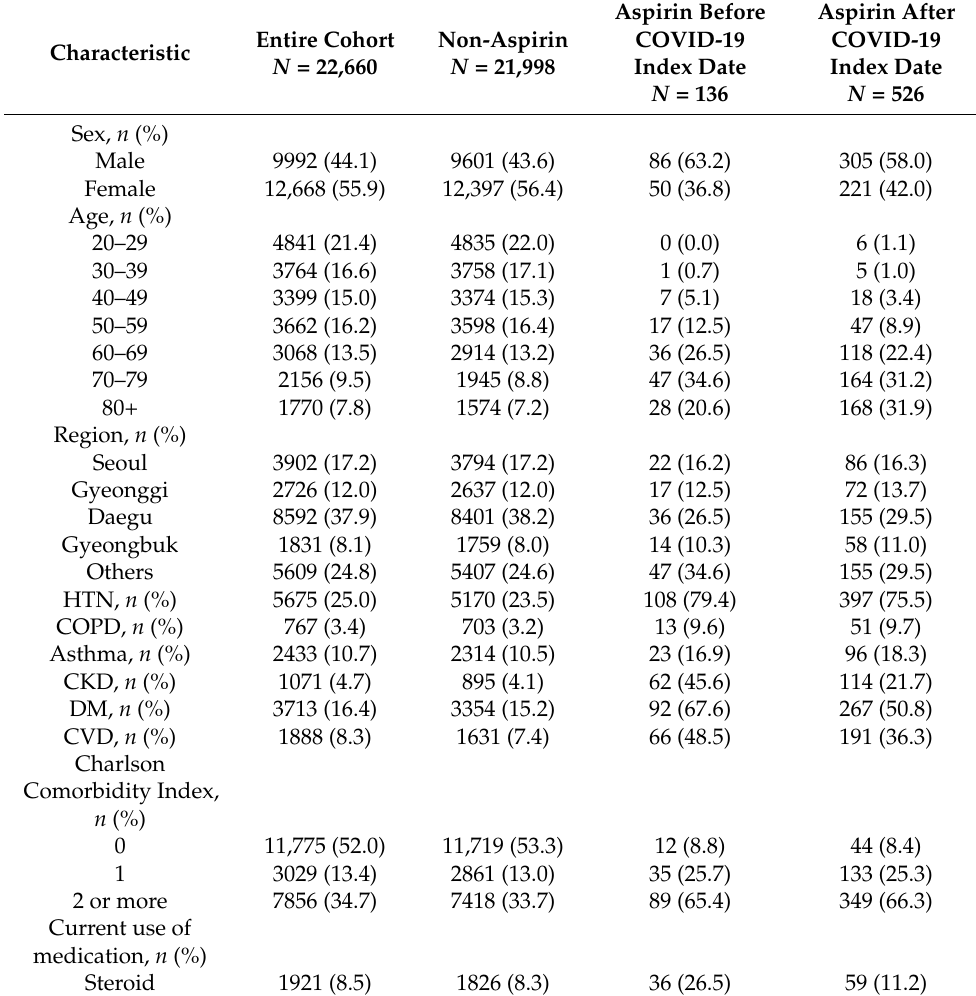
Table 1. Baseline characteristics of patients who were prescribed Aspirin before or after COVID-19 index date in NHIS COVID-19